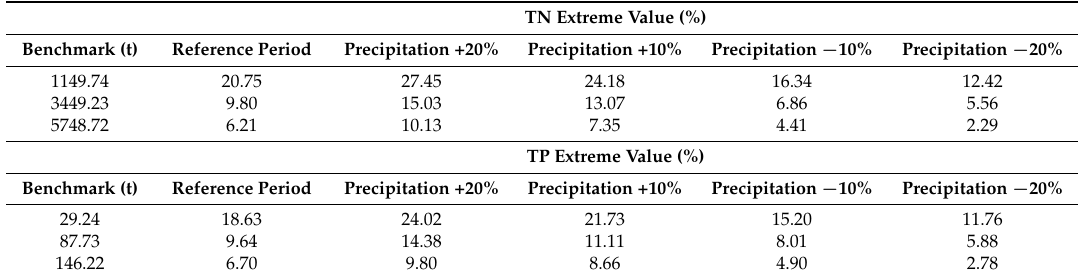
Table 7. The extreme values of TN and TP load under the Precipitation Change scenario.